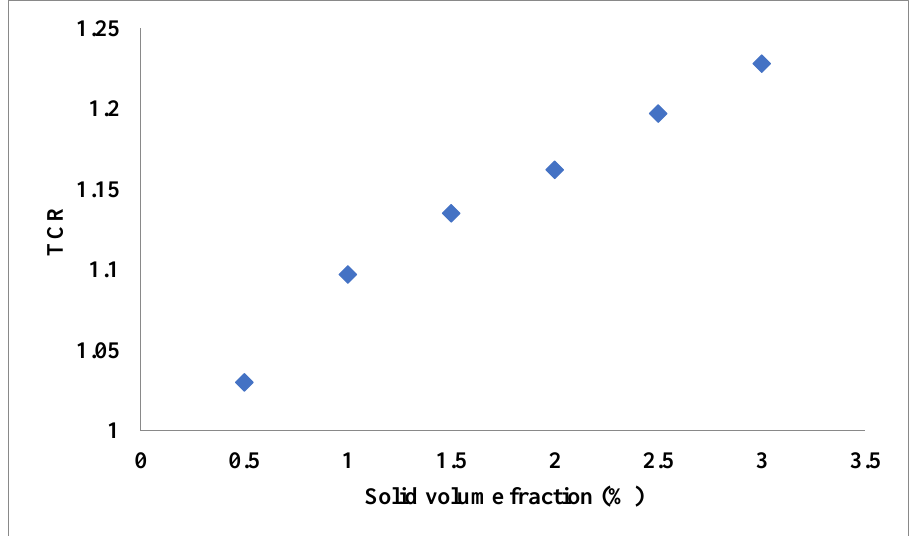
Figure 4. Influences of temperature and VF on TCR of SWCNT-ZnO/EG-water. Adapted from Ref. [49].